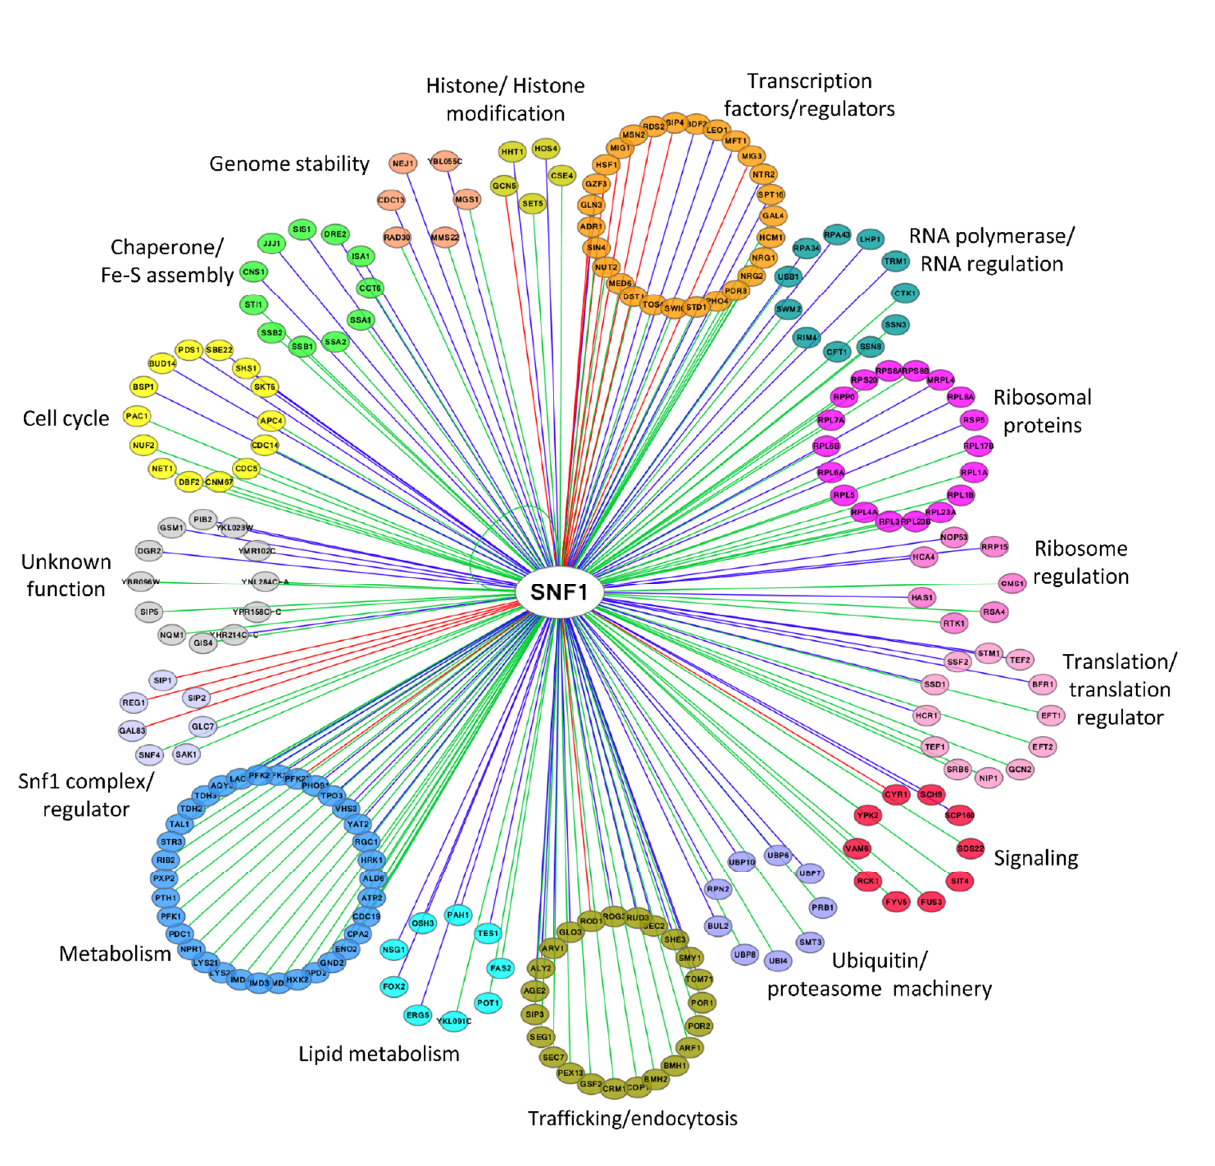
FIGURE 2 : Network of Snf1 physical interactors. The network reports the known physical associations obtained from SGD (Saccharomyces Genome Database, http://www.yeastgenome.org). Interactors are clustered according to their function and colored differently. When the interactor is also a substrate of Snf1 according to the Yeast Kinase Interaction Database (KID, http://www.moseslab.csb.utoronto.ca/KID/; [44]), the edge is colored in red if phosphorylation was analyzed by low throughput assays (LTP in vitro kinase assays; in vitro phosphorylation site mapping; in vivo phosphorylation site mapping; phosphorylation reduced or absent in kinase mutant) or in blue if phosphorylation was assayed only by high throughput analysis (protein chip data for in vitro phosphorylated substrate; HTP in vitro phosphorylation). Data visualization and analysis was performed with Cytoscape